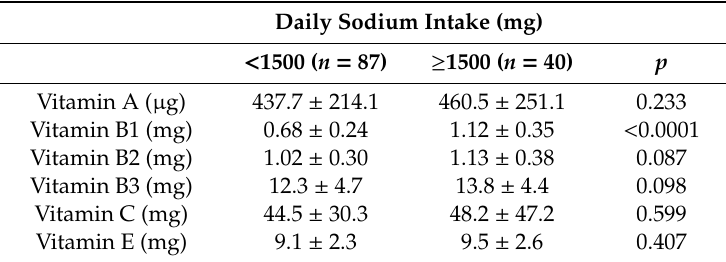
Table 4. Daily dietary intake (mean ± SD) of vitamins according to the daily sodium intake.